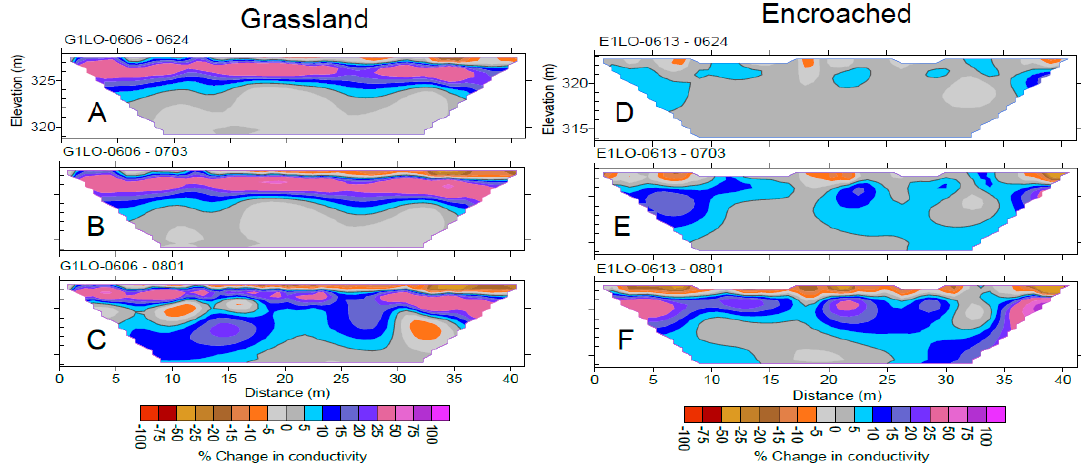
Figure 2. Time-lapse electrical resistivity (ER) image under grassland and grassland encroached by juniper (Modified from [30]). Images are transient images (background image minus subsequent ER dataset) showing % change in conductivity. A positive change indicates higher electrical conductivity (higher water content). Background data were taken in June 2014. Conductivity decreased at the lateral distance of 14 to 42 m in the top soil mantle ( A – C ), but increased by 5 to 50% below 1 m depth under grassland; indicating higher potential for deep drainage and recharge. Percent change in conductivity was relatively low under juniper encroachment ( D – F ) compared with grassland. For details, see Acharya et al. [30]. Table 2. Studies using different recharge estimation methods in the context of woody plant encroachment.